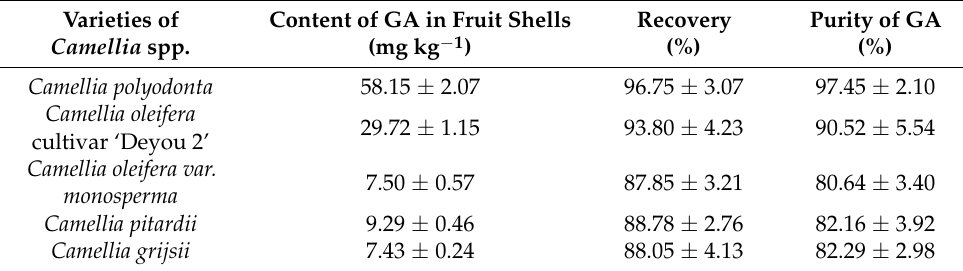
Table 6. Effects of DES@MIPs on the recovery of GA from different Camellia spp. fruit shells. Varieties of Camellia spp.